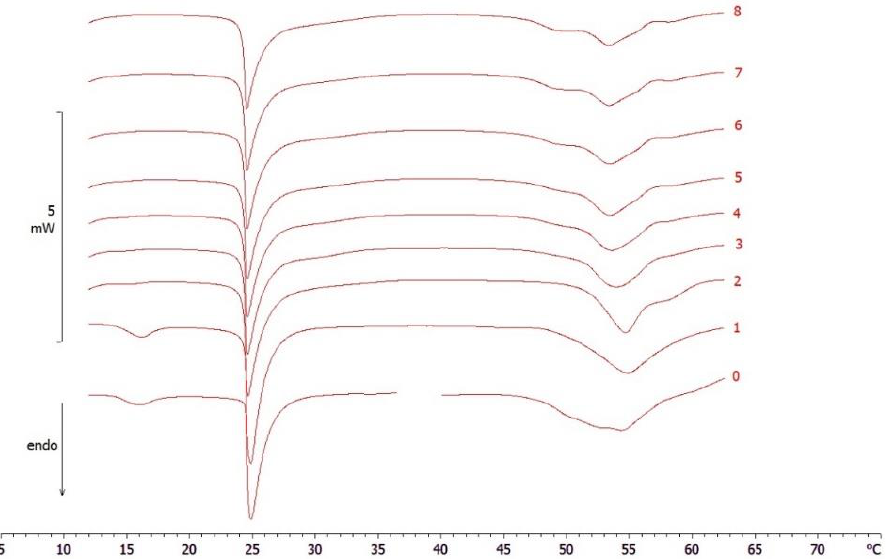
Figure 9. Calorimetric curves, in heating mode, of MLV put in contact with SLN-BXL at pH 5, at increasing incubation time. The numbers on the right side of the curves refer to the calorimetric scans. The curves 0 refer to the samples before contact.